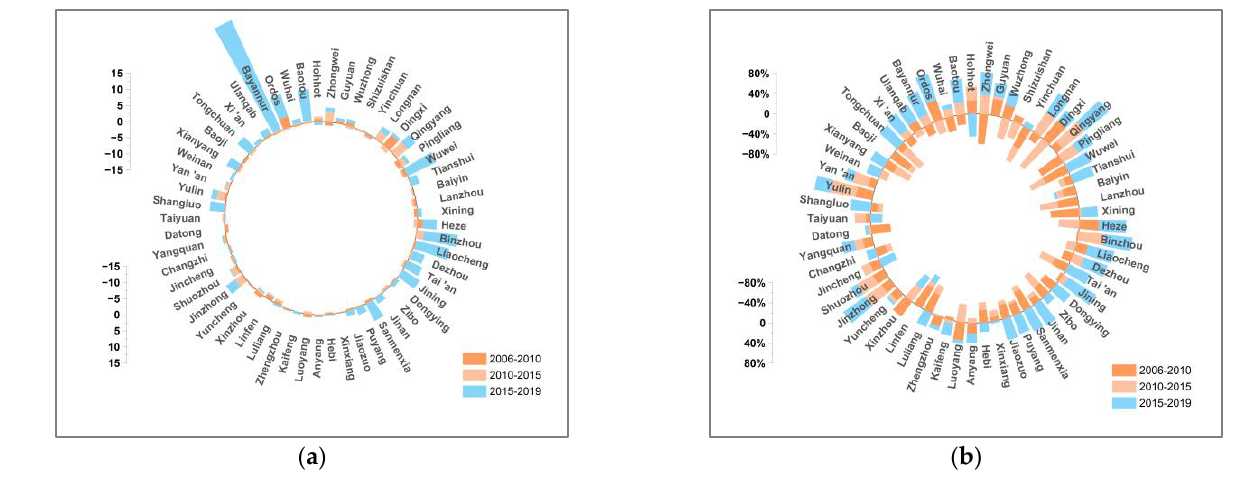
Figure 8. Contribution and contribution rate of economic-output factor. ( a ) Contribution of eco- nomic-output factor. ( b ) Contribution rate of economic-output factor.